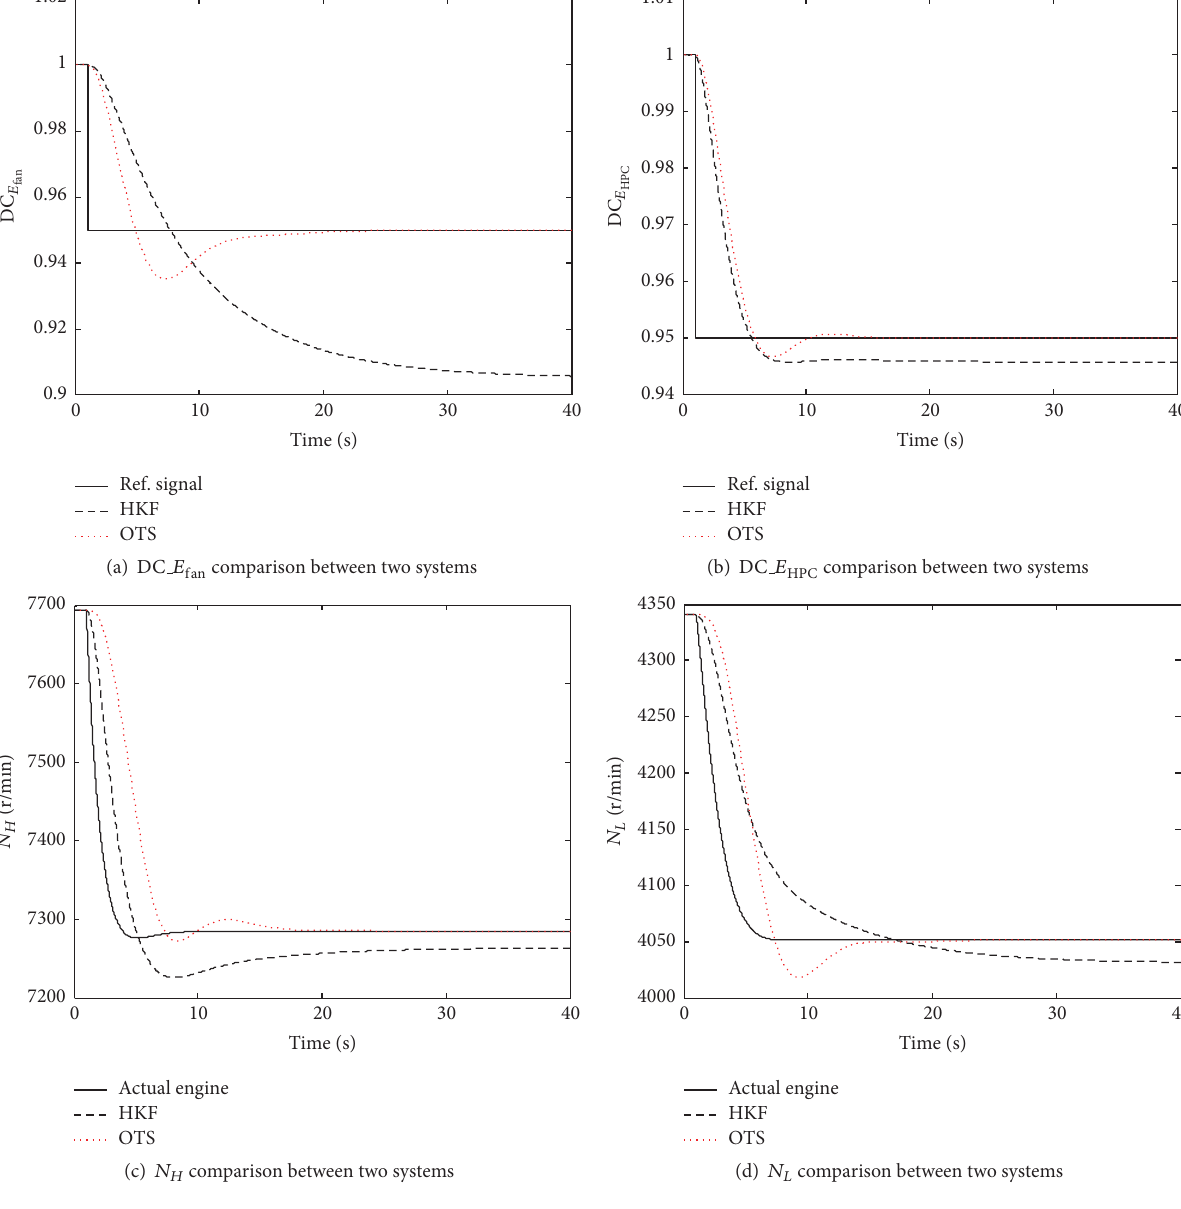
Figure 10: Comparisons of estimated results between the HKF and